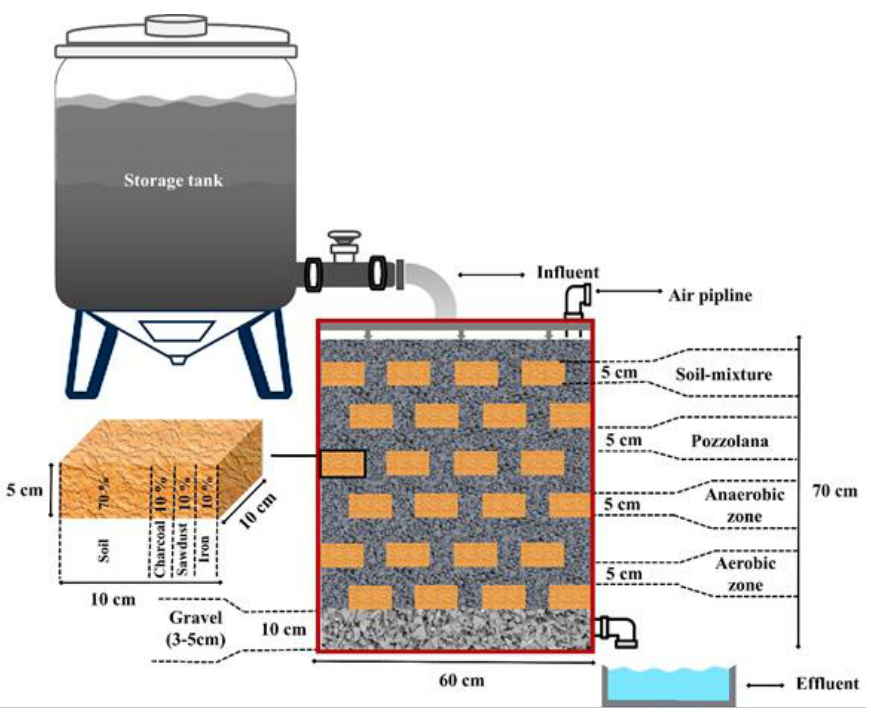
Figure 1. Scheme of Multi-Soil-Layering (MSL) pilot